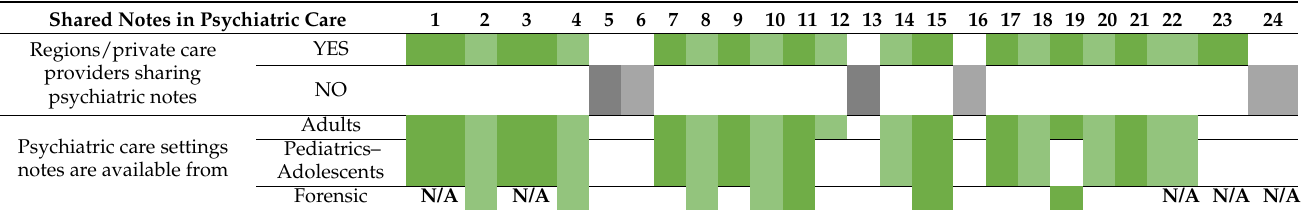
Table 1. Whether psychiatric notes are shared and, in such cases, from which psychiatric care setting for each region/private care provider. Note: (Light and dark) green colour = YES we share, (light and dark) grey colour = NO sharing, and N/A = not applicable. (Region number) 1 Blekinge, 2 Dalarna, 3 Gotland, 4 Gävleborg, 5 Halland, 6 Jämtland/Härjedalen, 7 Jönköping, 8 Kalmar, 9 Kronoberg, 10 Norrbotten, 11 Skåne, 12 Stockholm, 13 Sörmland, 14 Uppsala, 15